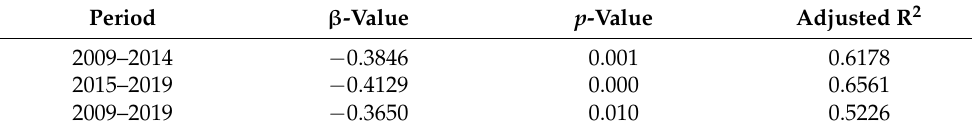
Table 6. Conditional β -convergence test results of cultivated land use efficiency in China. Period β -Value p